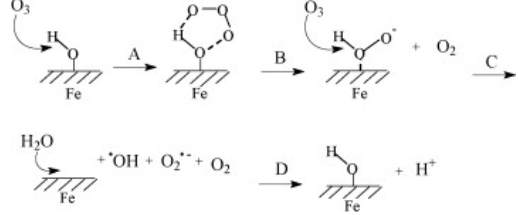
Figure 3. Distribution of different surface hydroxyl species on FeOOH as a function of pH.